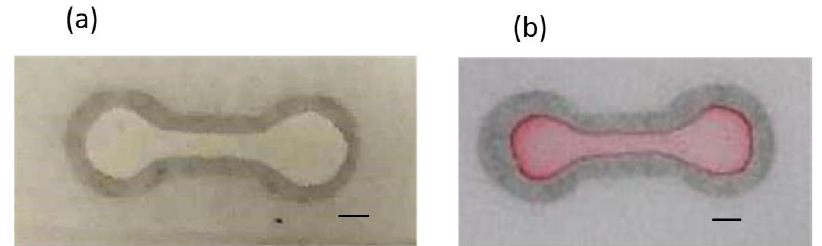
Figure 5. ( a ) The printed paper after spraying PDMS mixture. ( b ) The ink solution wicking through channel without leakage. Scale bar: 5